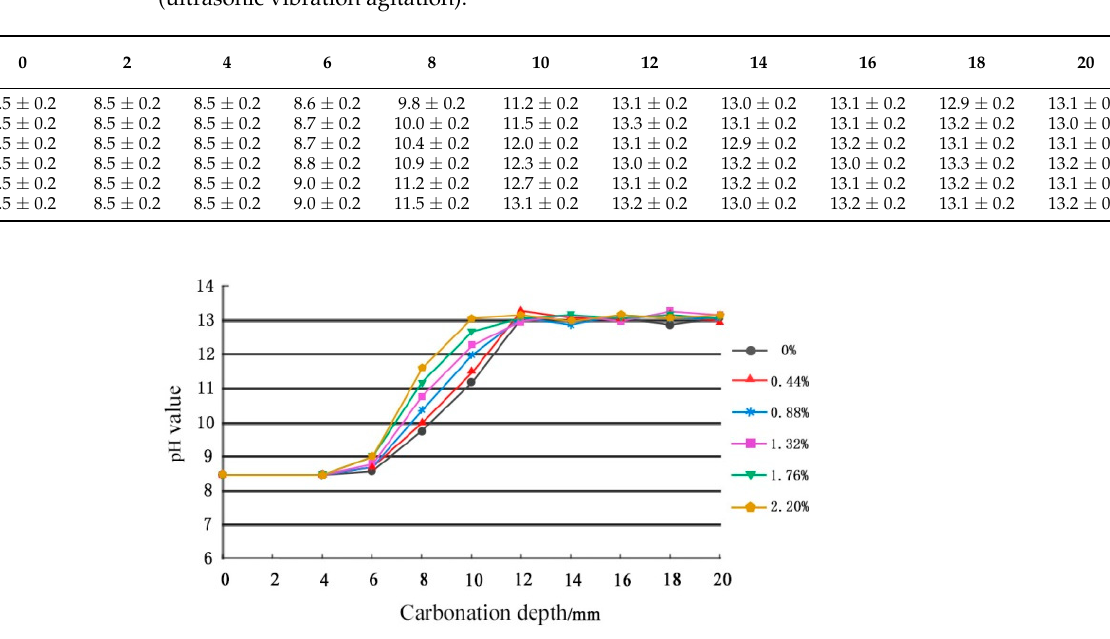
Figure 9. pH distribution of CO 2 ‐ absorbing cement mortar for 28 days (mechanical agitation). According to the tested pH values at different carbonation depths, zones with great variation in pH value are mainly concentrated within the carbonation depth range of 6 to 12 mm. It can be seen from Figure 9 that the pH of the carbonation zone decreases with the increase of CO 2 AA by the cement mortar. The test results and distribution patterns of the pH value of the carbonation zone of the hardened paste after CO 2 absorption under ultrasonic vibration agitation stirring (28 d) are shown in Table 6 and Figure 10. Table 6. pH value at 28 d in carbonized area of cement mortar with different CO 2 absorption (ultrasonic vibration agitation).